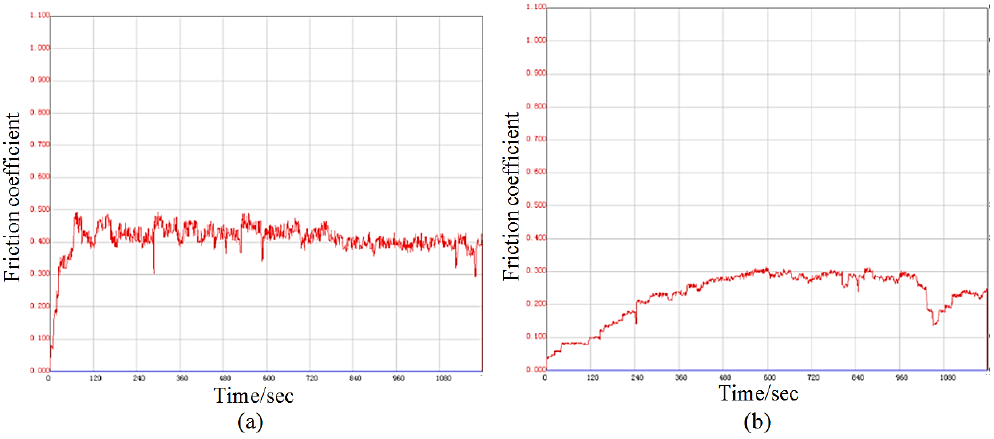
Figure 7. Friction and wear curve for the copper substrate ( a ) and Ni–Co coating ( b